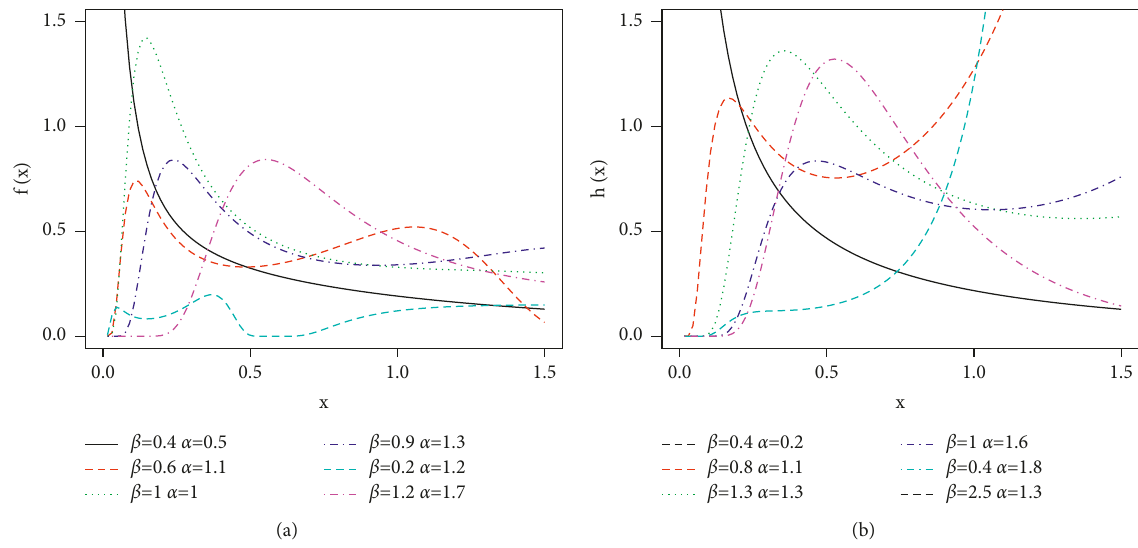
Figure 3: Graphical representation for the plots of the LCGa: (a) density and (b) hazard rate using certain values of the